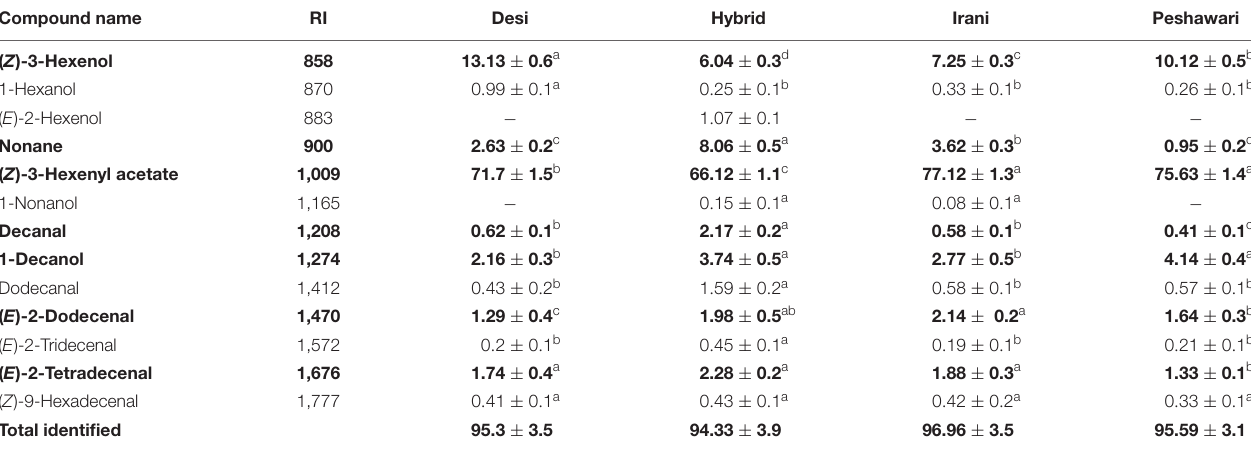
TABLE 1 | Percentage composition of compounds detected in the headspace of fresh coriander leaves of four coriander